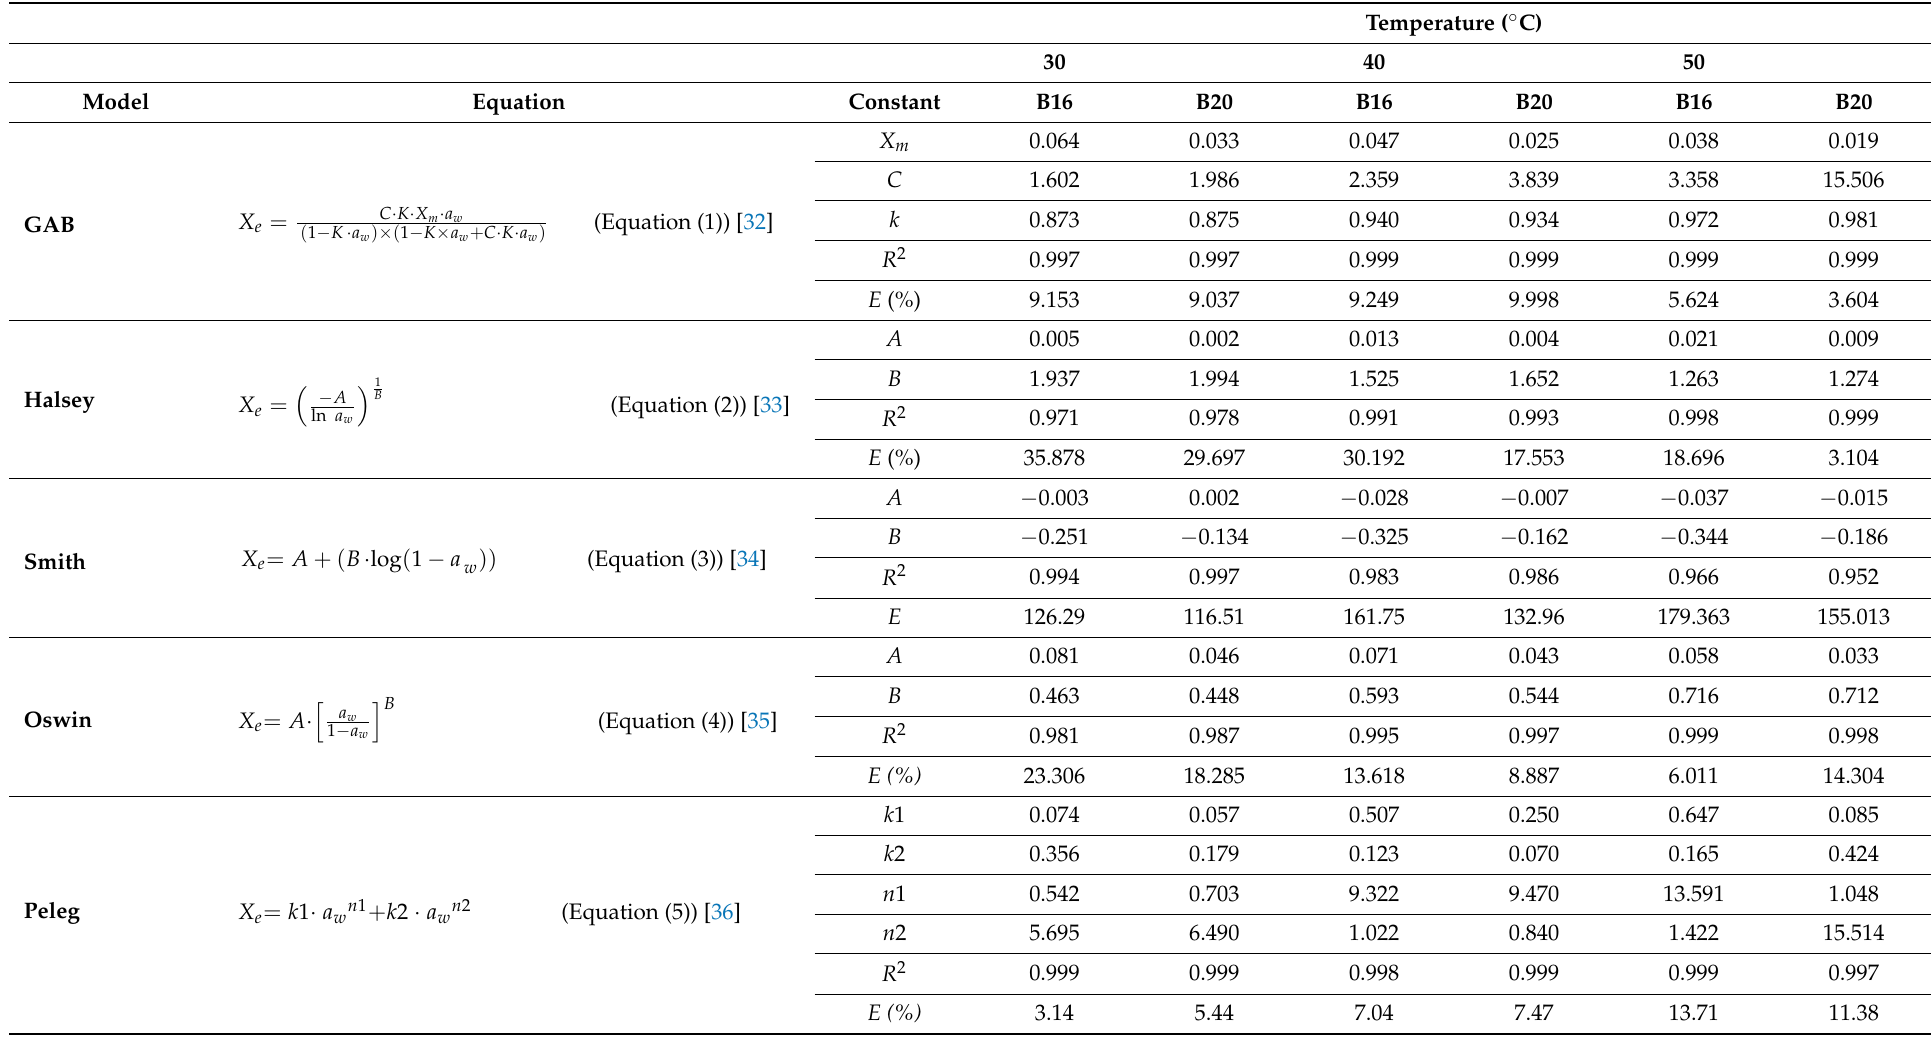
Table 1. Estimated values of coefficients evaluated using different models for the isotherms of B16 and B20 at 30, 40, and 50 ◦